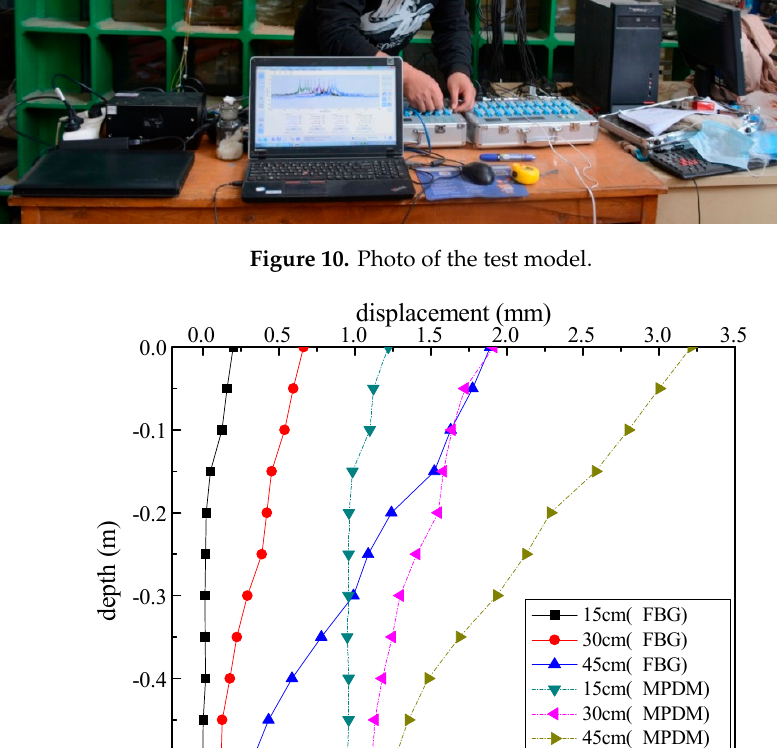
Figure 11. The test results of two monitoring